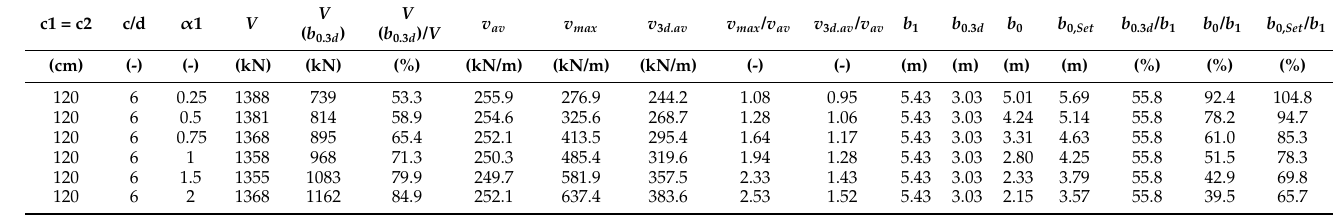
Table A3. Analysis of the shear force distribution in the control perimeter 0.5 d with 120 cm shear cap size.